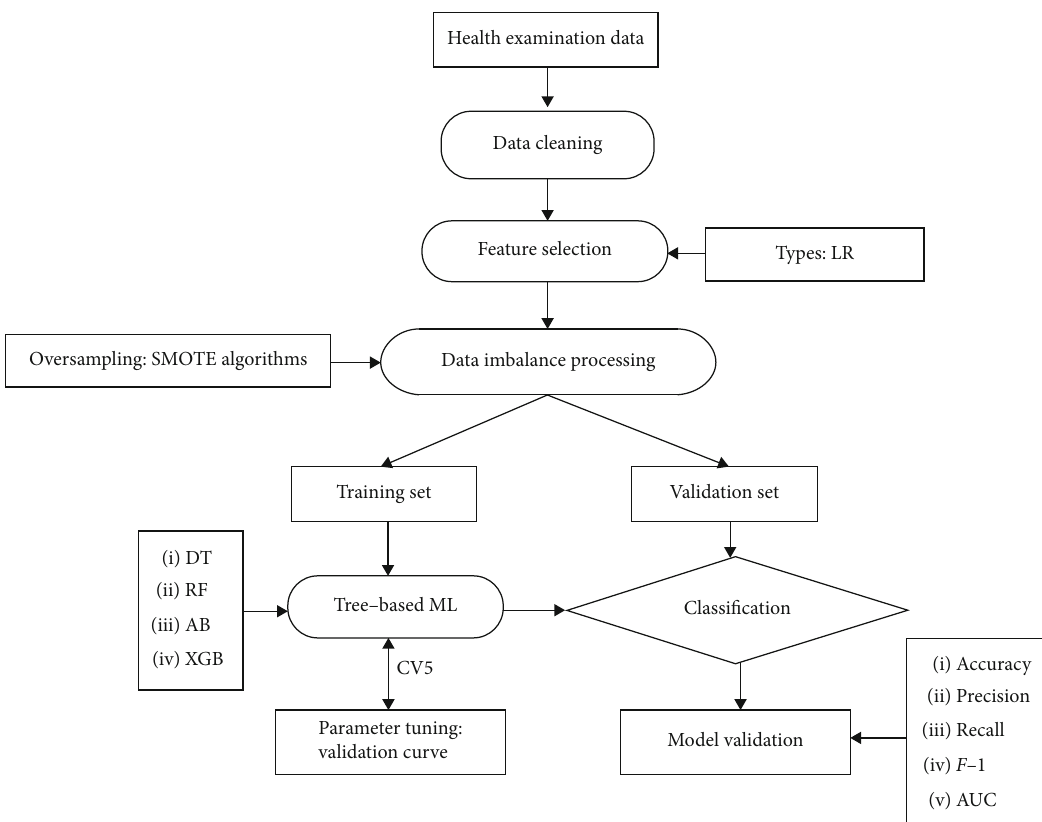
Figure 1: Machine learning fl owchart of this study. Abbreviations: LR: logistic regression; DT: decision tree; RF: random forest; AB: AdaBoost; XGB: XGBoost; ML: machine